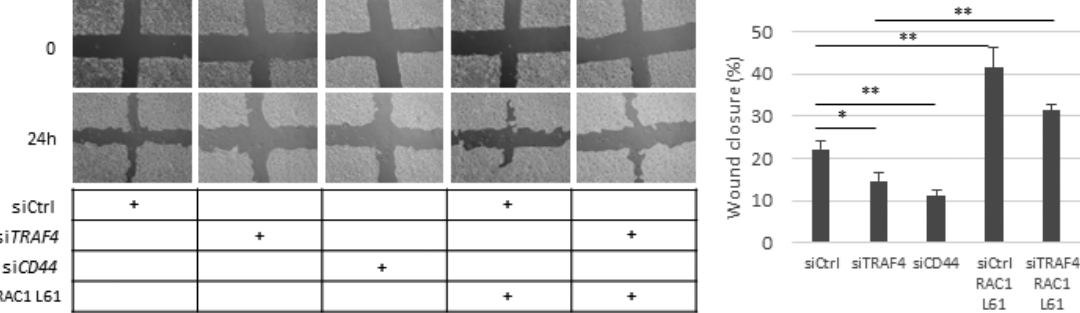
Figure 6. Knockdown of TRAF4 diminishes cell motility, which is rescued by constitutively active RAC1. A549 cells were transfected with control siRNA or siRNAs targeting TRAF4 or CD44 and co-transfected with either empty vector or the constitutively active RAC1 L61 mutant. Cell migration was evaluated using a cell culture wound healing assay. Pictures of the cell cultures were taken at 0 h and at 24 h. The results are presented as a percentage of wound closure and illustrate the average values ± SEM out of three independent experiments. Asterisks illustrate significant differences between the conditions indicated with lines: * p < 0.05, ** p < 0.01, *** p < 0.001.